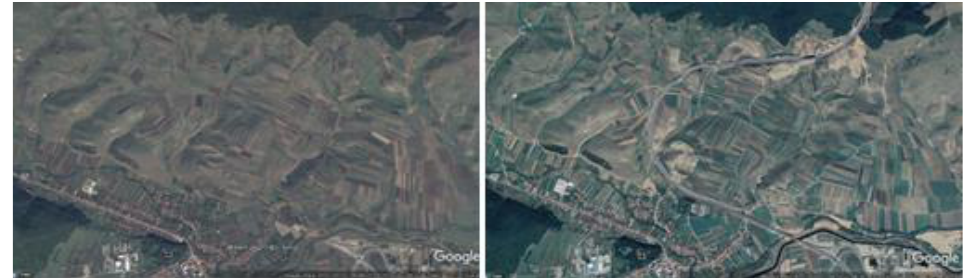
Remote Sens. 2022 , 14 , 6011 17 of 20 Figure 10. Construction of a sector from the A3 highway Gilău - Nădăşelu : 2013 ( left ) and 2019 Figure 10. Construction of a sector from the A3 highway Gilău - Nădăşelu : 2013 ( left ) and 2019 Figure 10. Construction of a sector from the A3 highway Gil ă u-N ă d ă ¸selu: 2013 ( left ) and 2019 ( right ). Figure 10. Construction of a sector from the A3 highway Gilău - Nădăşelu : 2013 ( left ) and 2019 ( right ). ( right ). ( right ).